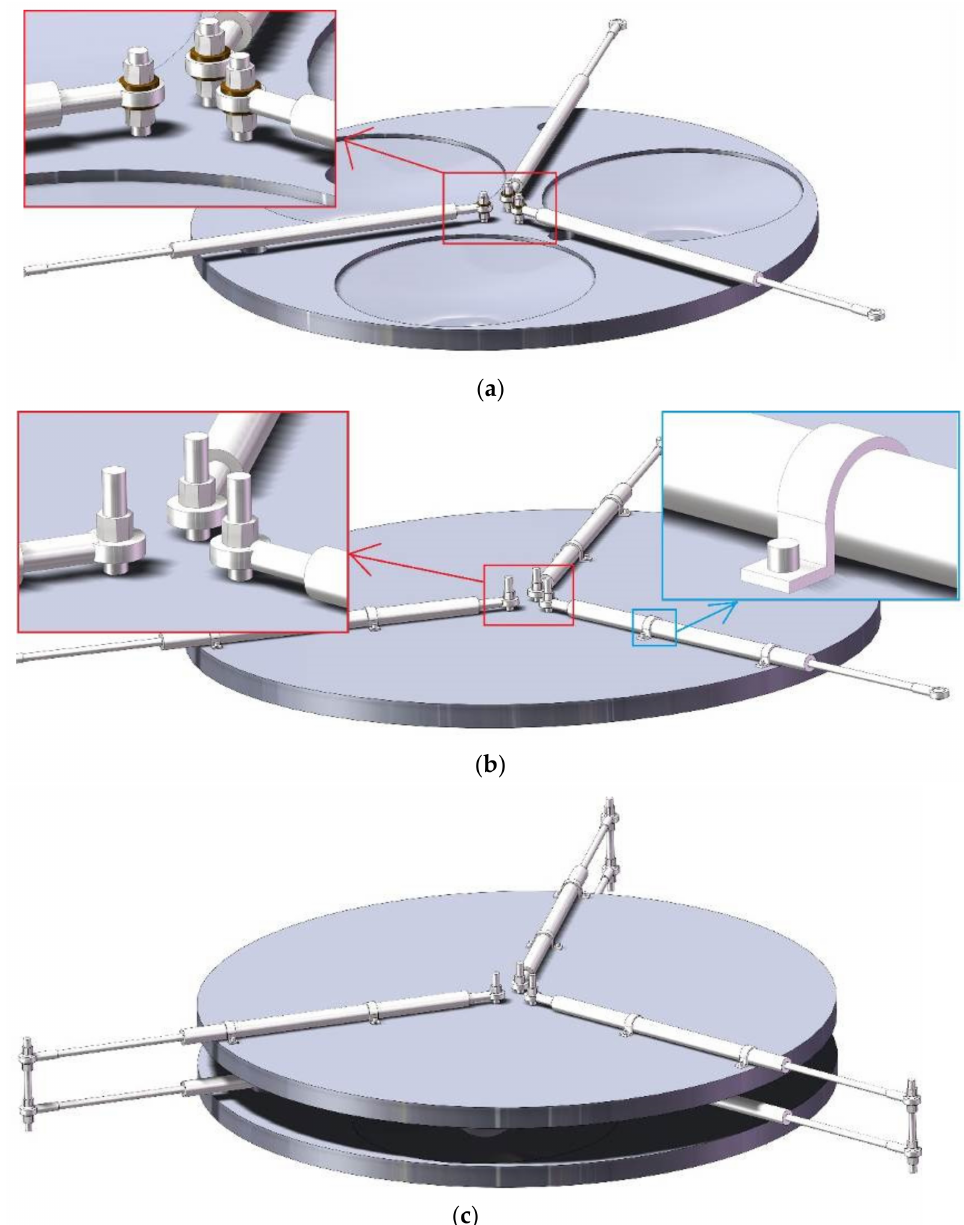
Figure 11. ( a ) Schematic diagram of the connection between the damper with the lower support plate and ( b ) the upper support plate, ( c ) overall connection